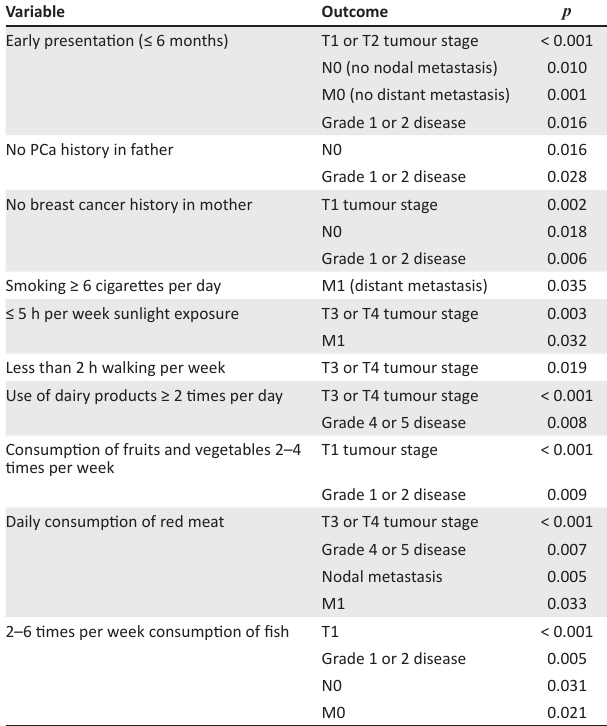
TABLE 5: Disease stage and grade at diagnosis among participants ( n = 341).